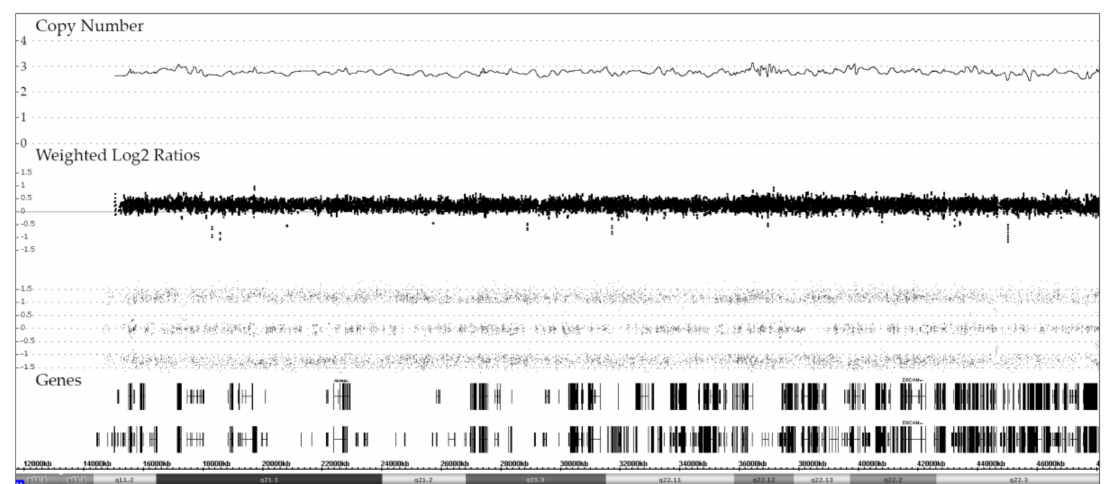
Figure 6. Array image of a unique dic(9;20) case with three chromosome 21 copies and an evenly balanced heterozygous allele pattern. The presence of the trisomy was verified with FISH and the biallelic allele pattern with STR analyses (data not shown). The karyotype of the leukemic cell population is 46,XX,del(2)(p23?)[3],dic(9;20)(p13;q11),+21 and the array one 46,XX,del(9)(p24.3p13.1),del(9)(p21.3)x2,del(20)(q11.21q13.33)/dic(9;20),+21, respectively.